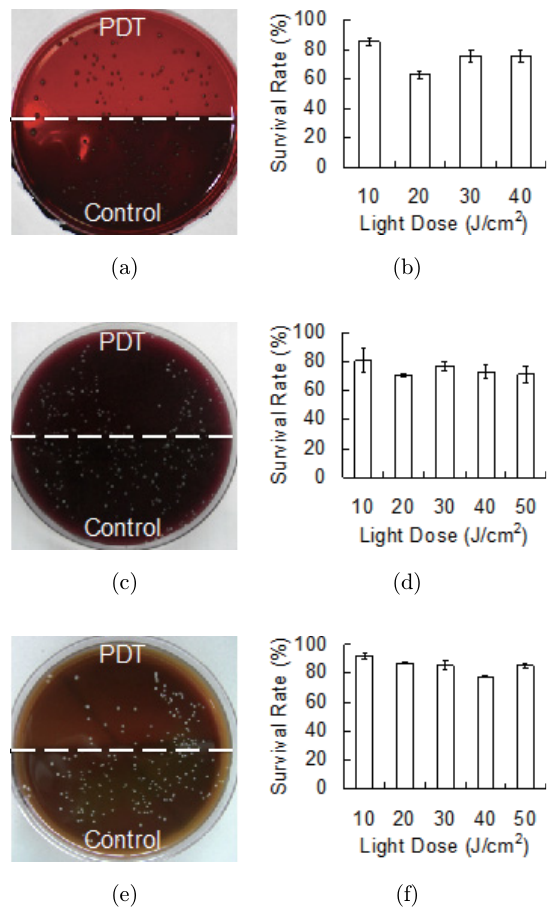
Fig. 3. Endogenous PDT (with blue light and endogenous photosensitizer) e®ects on three pathogenic bacteria of peri- odontitis: (a) Typical P : m : plate after endogenous PDT;